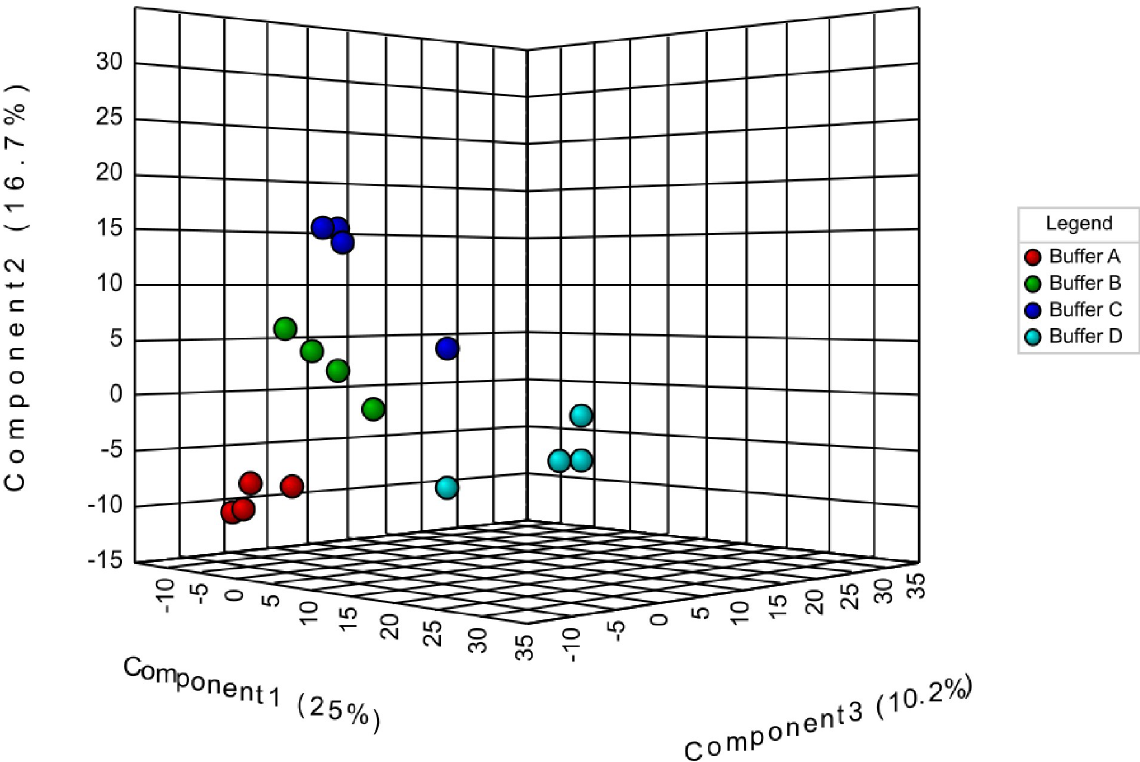
Fig 7. Three-dimensional scores plot from PLS-DA representing proteomics data from the evaluation of four different solubilization buffers. Buffer A: Urea/thiourea/CHAPS; Buffer B: Urea/CHAPS; Buffer C: Urea/Sodium deoxycholate; Buffer D: Sodium deoxycholate.